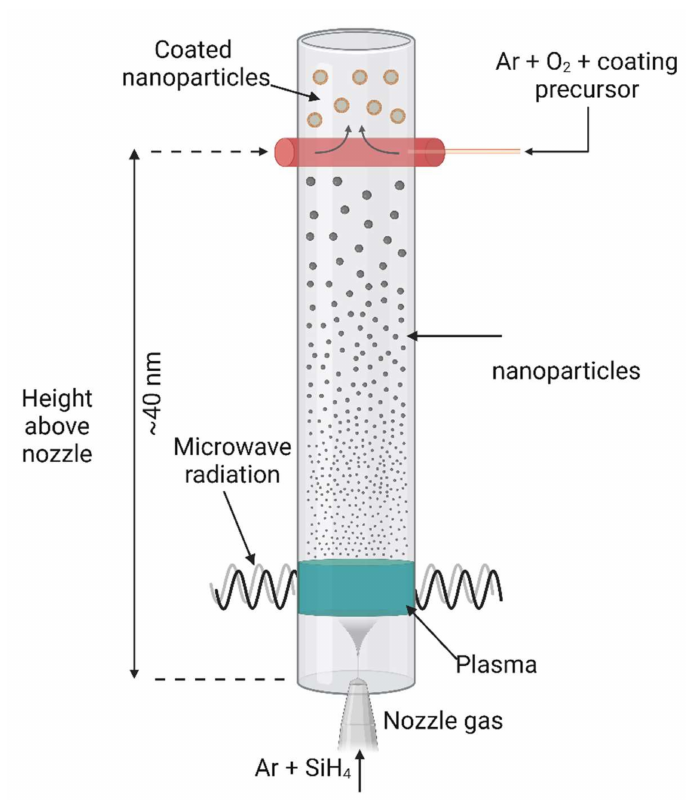
Figure 7. Representation of plasma-assisted gas phase synthesis of silicon-coated nanoparticles. Image created with